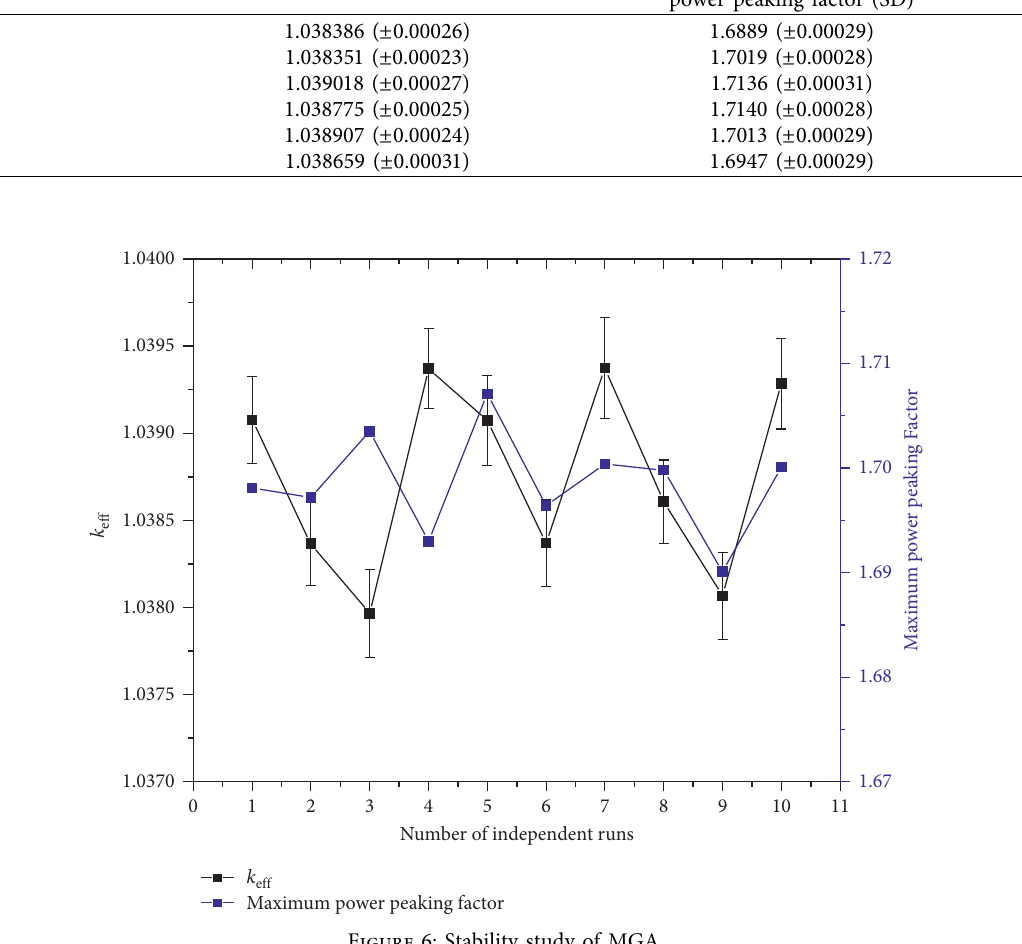
Figure 6: Stability study of